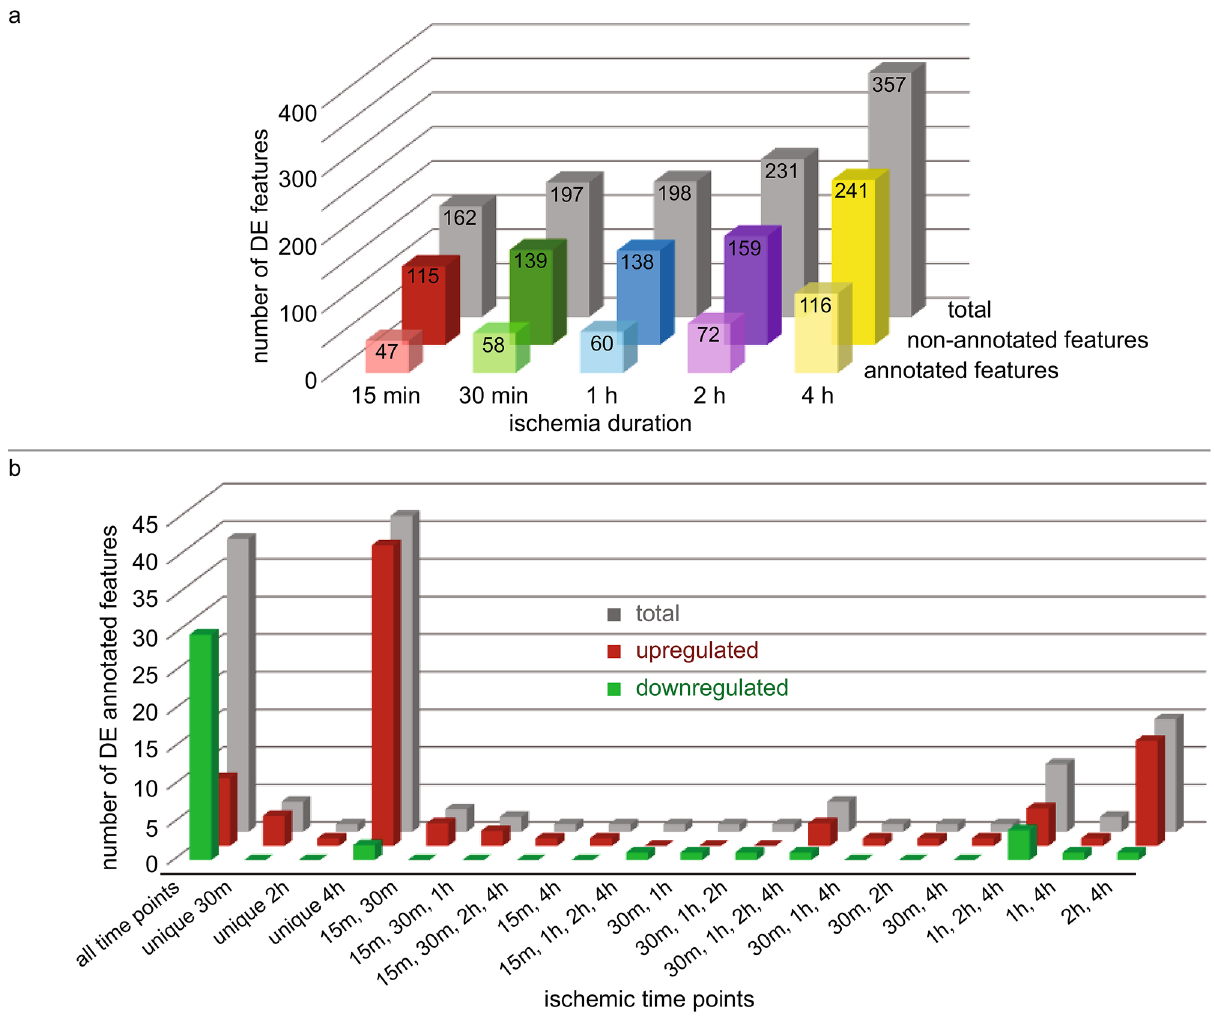
Figure 2. Number of annotated and non-annotated DE features. ( a ) Number of DE features at each time point: the number of both annotated and non-annotated features was increased with prolonged ischemia. ( b ) Number of annotated DE features according to temporal expression pattern and direction of regulation (up or down): changed at all time points, unique to a given time point, or differentially expressed at multiple ischemic